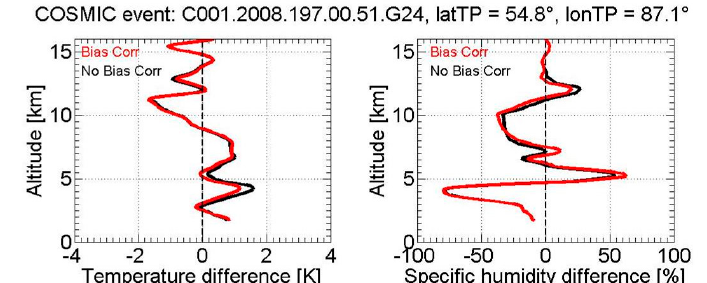
Figure A1. Differences between RO retrieved profiles and ECMWF co-located analysis profiles obtained from using the bias-corrected background profiles (red, “Bias Corr”) and from using the original background profiles (black, “No Bias Corr”) profiles for three exemplary RO events from simMetOp (upper), CHAMP (middle), and COSMIC (bottom) from 15 July 2008.